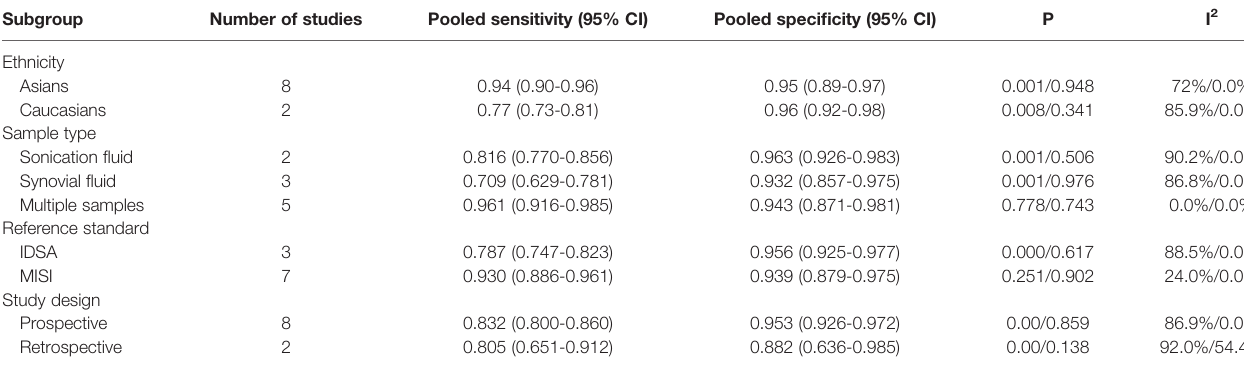
TABLE 3 | Subgroup analysis of